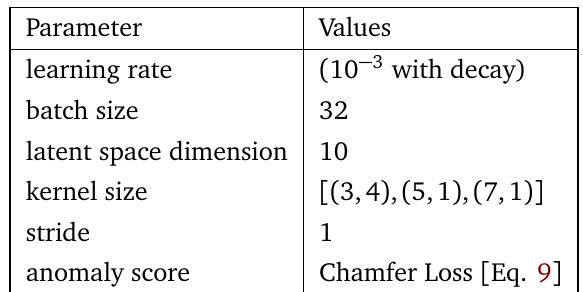
Table 9: ConvVAE